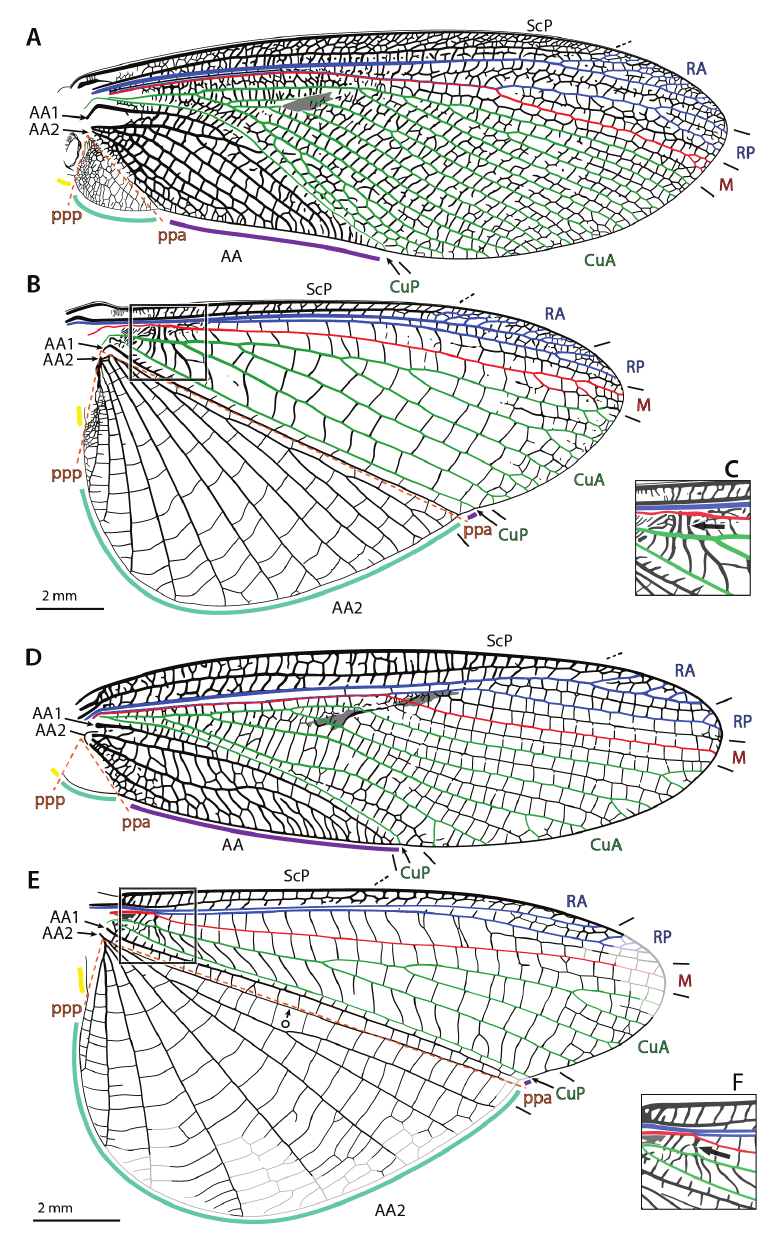
Figure 4. Annotated illustrations of fore- and hindwing venation and structures in Metallyticus splendidus Westwood, 1835 ( A – C ) and Chaeteessa sp. ( D – F ). A, D forewing B, E hindwing (in E , º indicates Iaa aa ) C, F detail of the arculus as located on B, E respectively (enlargement 1.5 × ; black arrow indicates the 2 arculus). Abbreviations: AA = anterior Analis; AA1 = first anterior Analis; AA2 = second anterior Analis; CuA = anterior Cubitus; CuP = posterior Cubitus; M = Media; ppa = plica prima anterior; ppp = plica prima posterior; RA = anterior radius; RP = posterior radius; ScP = posterior subcostal; color coded areas: gray = stigma ( sti ); purple = preplicatum; turquoise = plicatum; yellow =